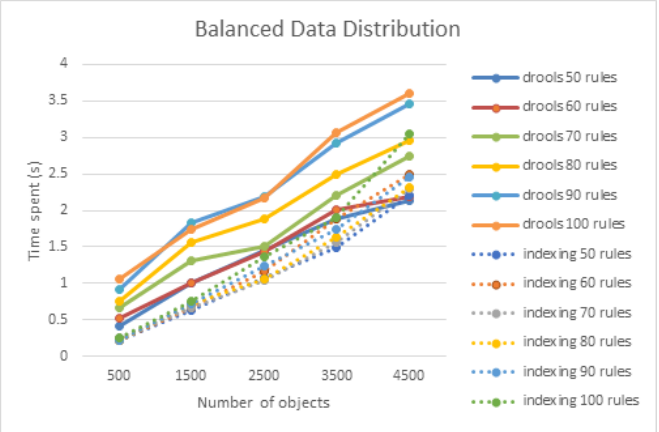
Figure 14. Performance effect of the number of objects on uniform object distribution compared to Drool.